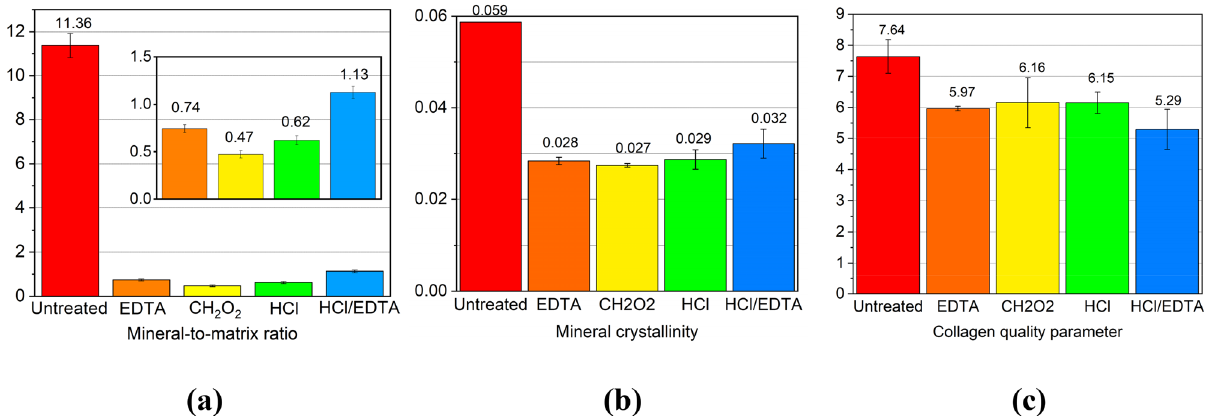
Figure 2. Raman spectroscopy analytical study of the mineral and collagen content for untreated bone, and for ethylene-diamine tetraacetic acid (EDTA), formic acid (CH 2 O 2 ), hydrochloric acid (HCl), and the HCl/EDTA mixture treated bone. (a) The inset is an enlarged plot of the mineral-to-matrix ratio. Mineral-to-matrix ratio is determined by the intensity ratio of v 1 PO 43- to amide III bands, (b) the mineral crystallinity is defined as 1/ FWHM of band v 1 PO, and ( c) the collagen quality is the area ratio of 1660/1690 cm −1 under amide I band.